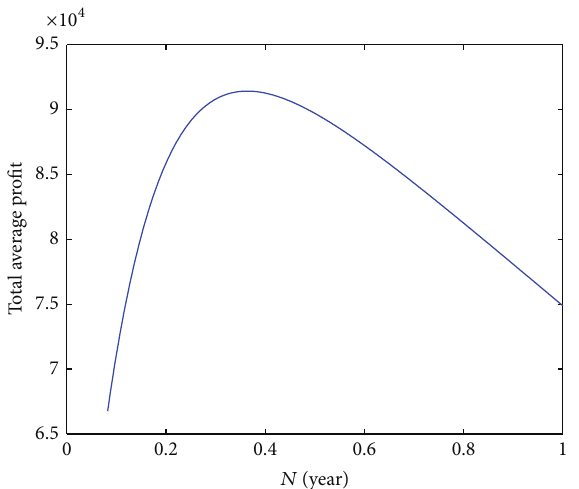
Figure 12: Optimal total average profit w.r.t. downstream credit period length of the second type demand.